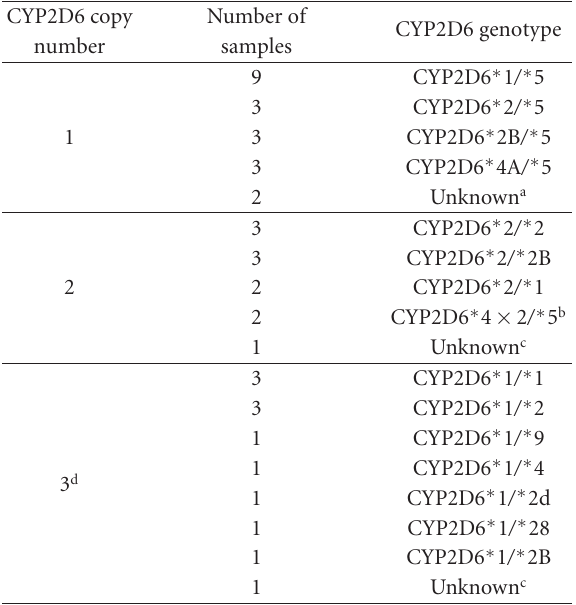
Table 1. CYP2D6 genotype of the samples included in this study. CYP2D6 copy